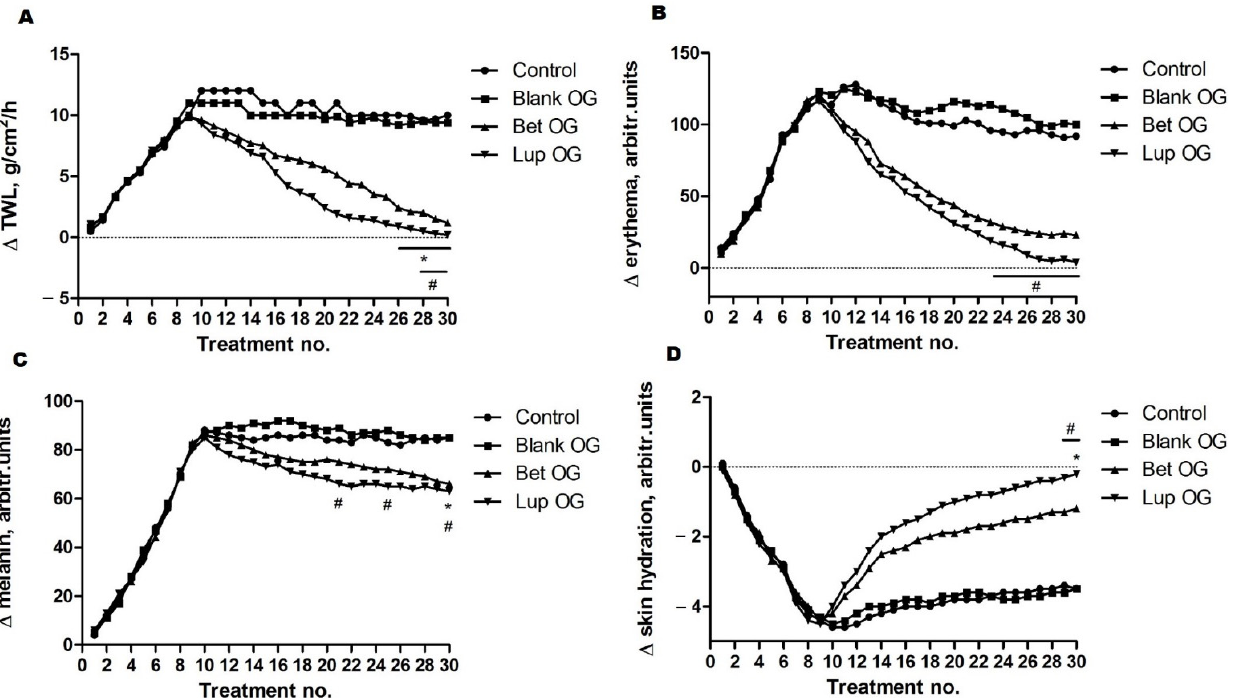
Figure 9. Comparative evolution of skin biophysical parameters: ( A ) Transepidermal water loss (for Lup and Bet OG vs. blank OG # p < 0.05; and for Lup, Bet, and blank OG vs. control * p < 0.05); ( B ) Erythema (for Lup and Bet OG vs. blank OG # p < 0.05); ( C ) Melanin (for Lup and Bet OG vs. blank OG # p < 0.05; and for Lup, Bet, and blank OG vs. control * p < 0.05); ( D ) Skin hydration (for Lup and Bet OG vs. blank OG # p < 0.05; and for Lup, Bet, and blank OG vs. control * p < 0.05). The statistical differences were determined using a two-way ANOVA analysis followed by a Bonferroni post-test.